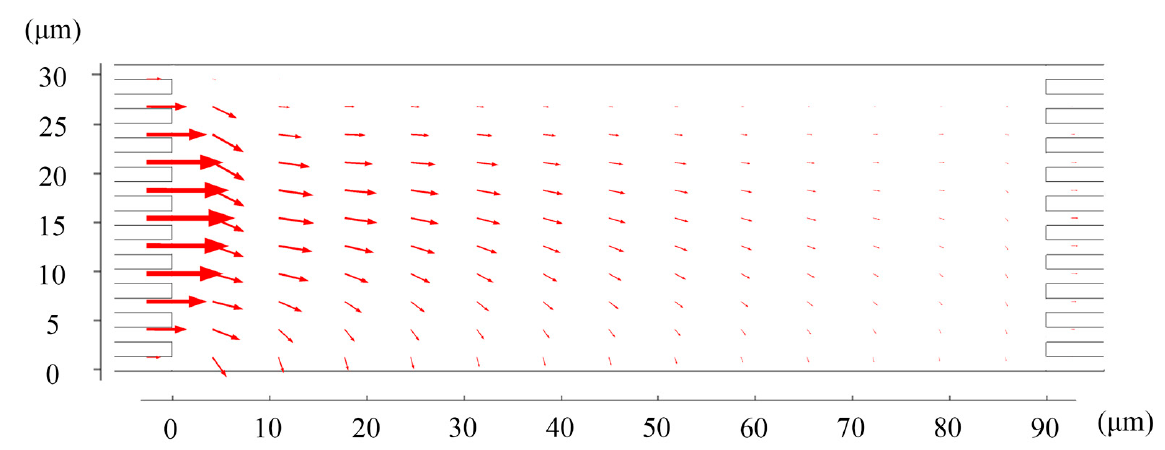
Figure 3. The flux distribution of Li + . Values of other parameters are: V = 30 V T , u out = 1 mm/s, u 1 = 0.63 mm/s, and u 2 = 1 mm/s.